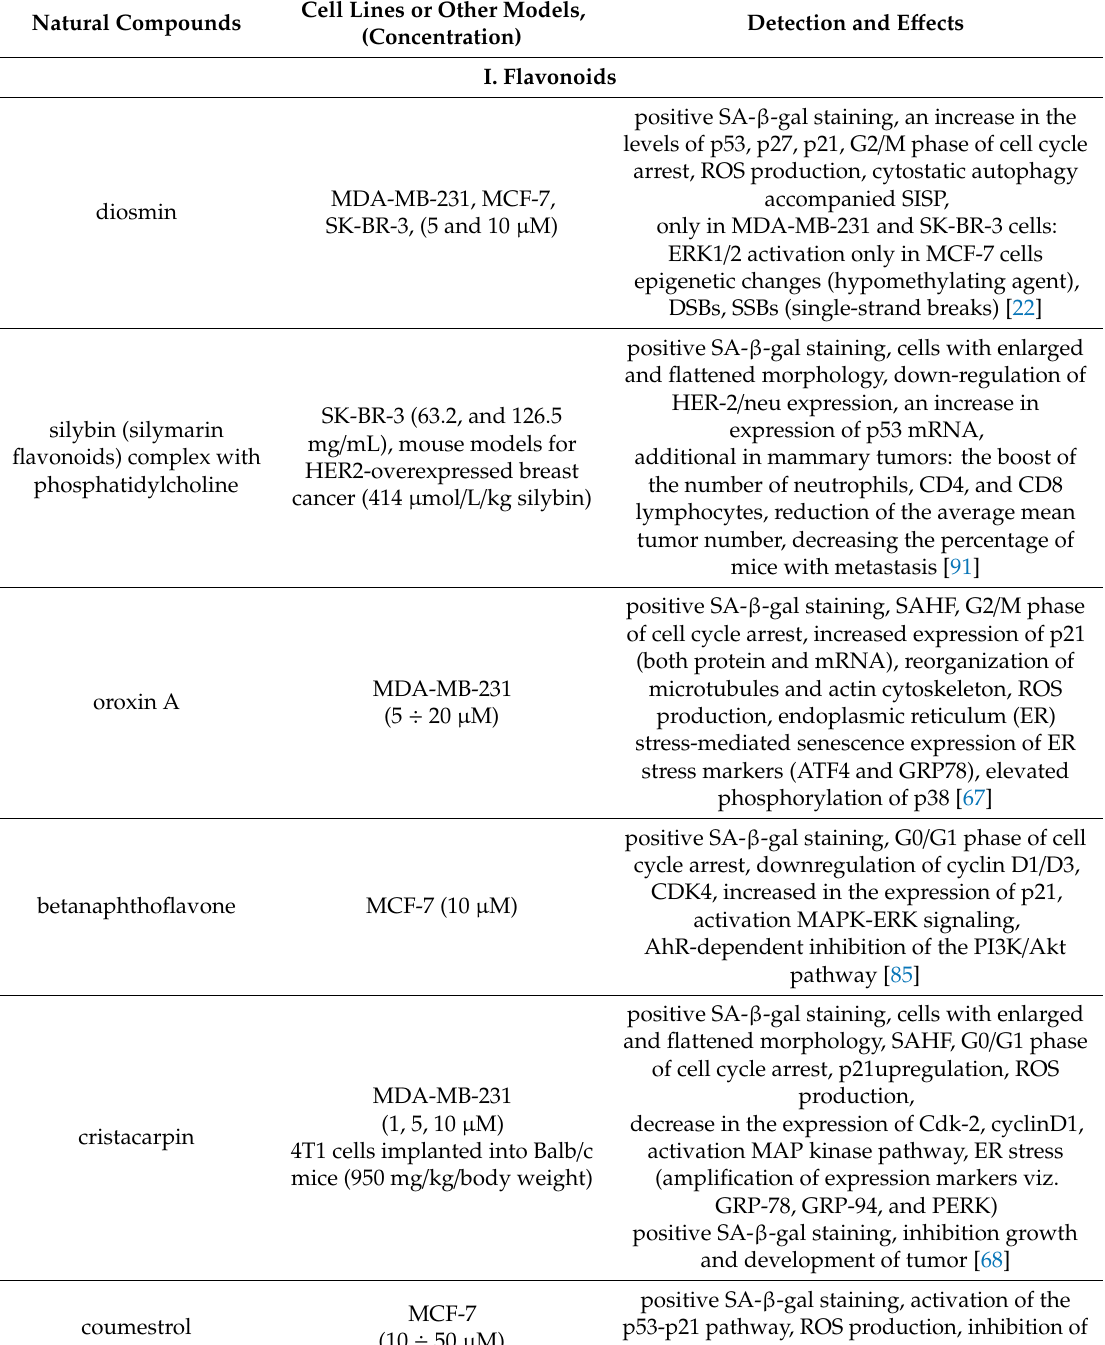
Table 4. Senescence induction via